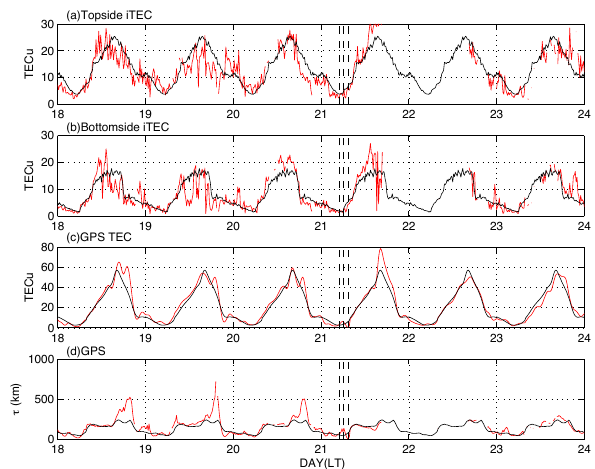
Fig. 6. Variations of (a) topside iTEC, (b) bottomside iTEC, (c) GPS TEC, and (d) ionospheric equivalent slab thickness ( τ) from 18 to 23 May 2012. The red and solid lines denote the observed and monthly mean values, respectively. The vertical dashed lines represent the onset, second contact, and ending time of the annular solar eclipse on 21 May